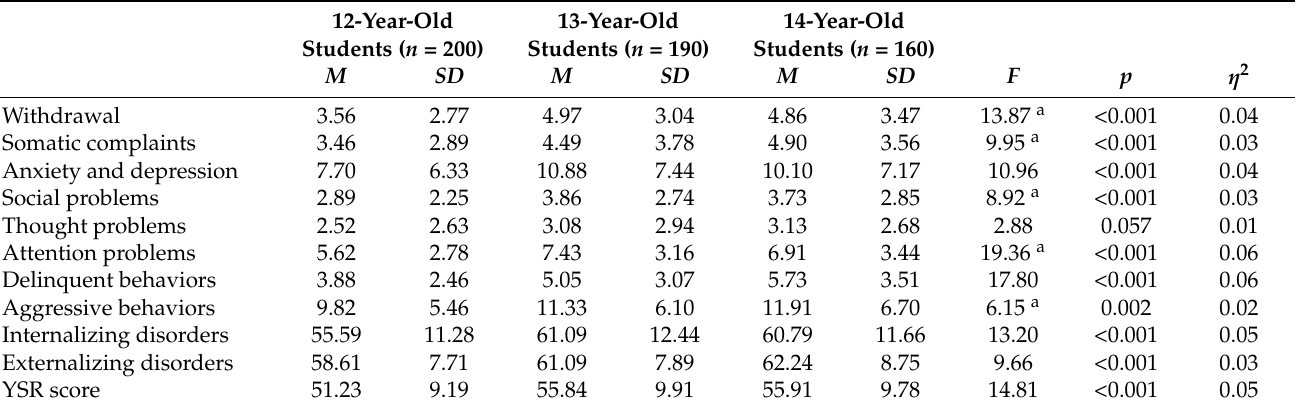
Table 4. Youth Self Report scale scores among 12-, 13-, and 14-year-old students.